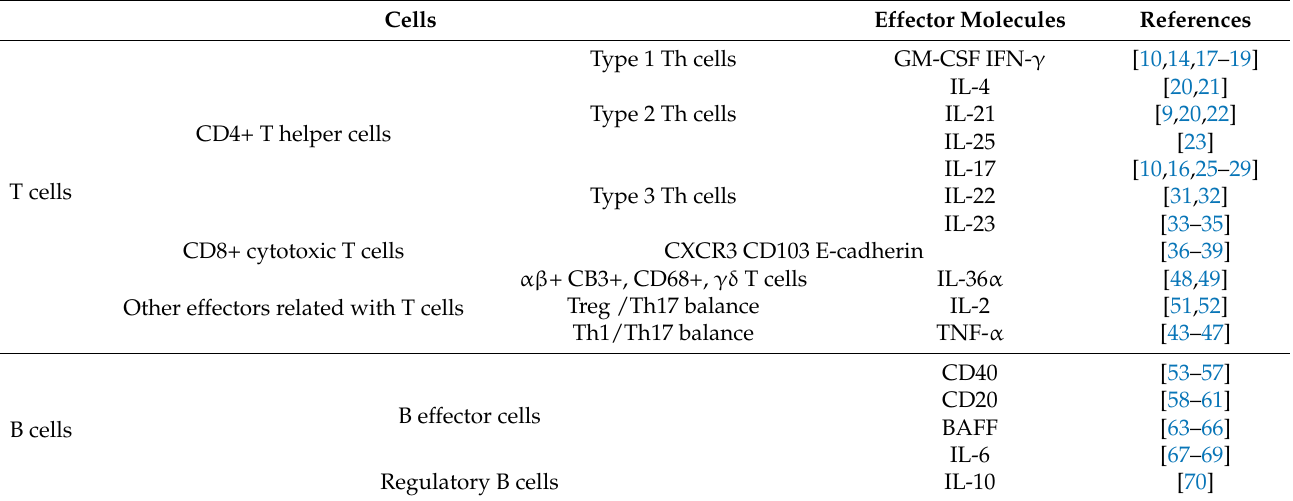
Table A1. Potential T and B cell targets for the development of treatment options for primary